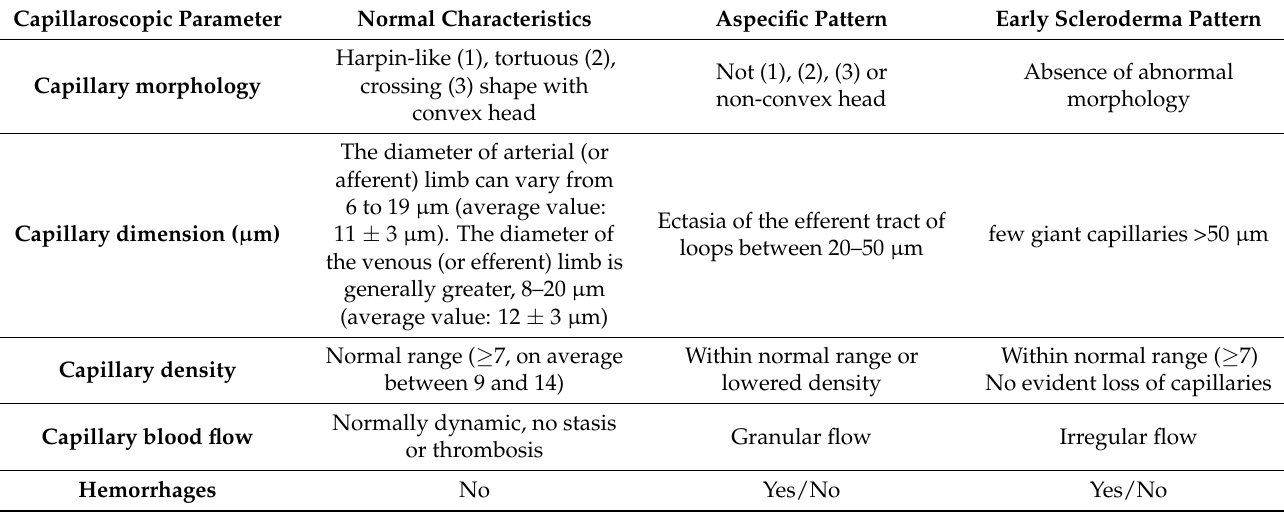
Table 1. Capillaroscopic parameters and relative characteristics for normal, aspecific and early scleroderma pattern. Capillaroscopic Parameter Normal Characteristics Aspecific Pattern Early Scleroderma Pattern Harpin-like (1), tortuous (2), Capillary morphology